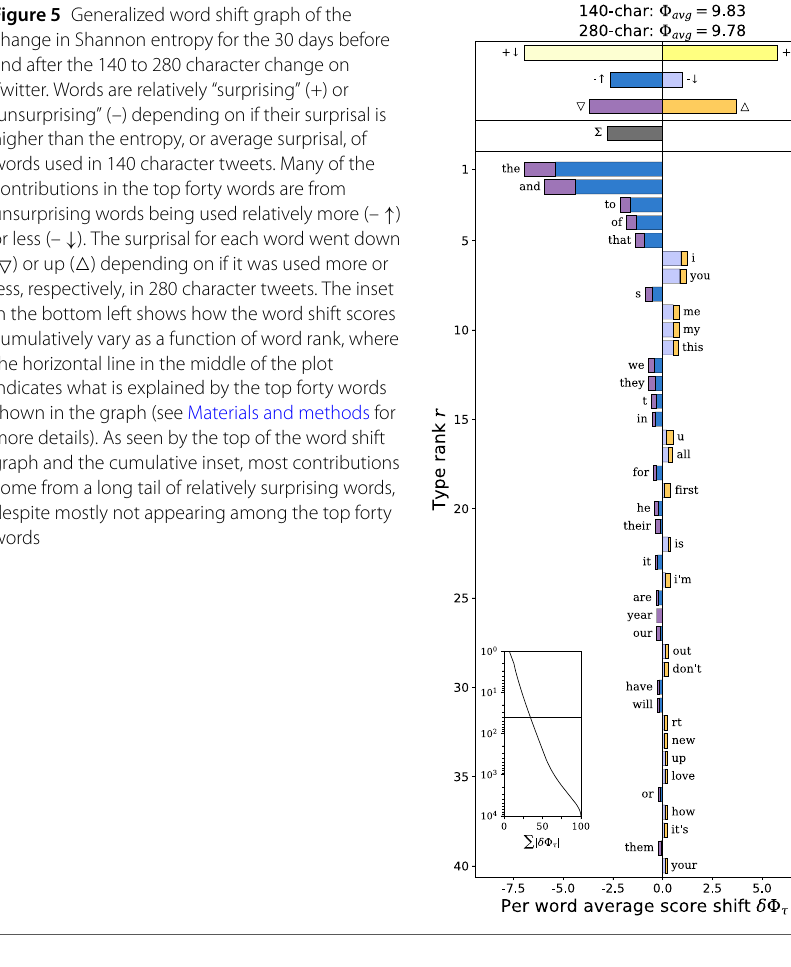
Figure 5 Generalized word shift graph of the change in Shannon entropy for the 30 days before and after the 140 to 280 character change on Twitter. Words are relatively “surprising” (+) or “unsurprising” (–) depending on if their surprisal is higher than the entropy, or average surprisal, of words used in 140 character tweets. Many of the contributions in the top forty words are from unsurprising words being used relatively more (– ↑ ) or less (– ↓ ). The surprisal for each word went down ( (cid:8) ) or up ( (cid:7) ) depending on if it was used more or less, respectively, in 280 character tweets. The inset in the bottom left shows how the word shift scores cumulatively vary as a function of word rank, where the horizontal line in the middle of the plot indicates what is explained by the top forty words shown in the graph (see Materials and methods for more details). As seen by the top of the word shift graph and the cumulative inset, most contributions come from a long tail of relatively surprising words, despite mostly not appearing among the top